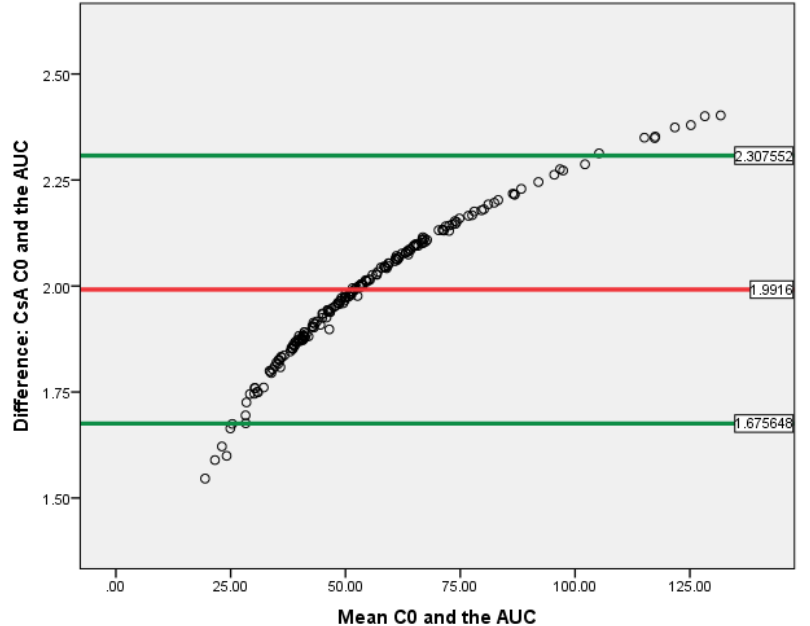
Figure 9. Bland–Altman plot for CsA C 0 and AUC (0–12) in kidney recipients. The horizontal red line delineates the log-mean di ff erence between C 0 and AUC (0–12) , the upper and the lower horizontal green lines delineate ± 1.96 × standard